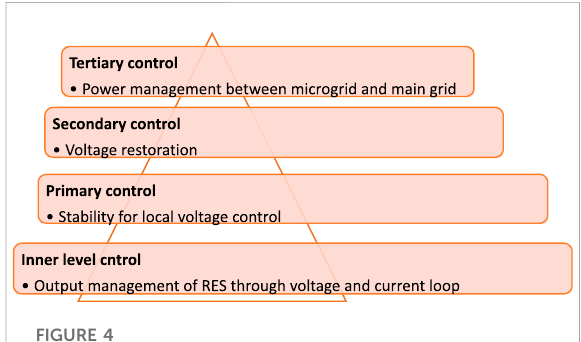
FIGURE 4 Hierarchical level control structure for microgrids. SOURCE: (Shuai et al.,